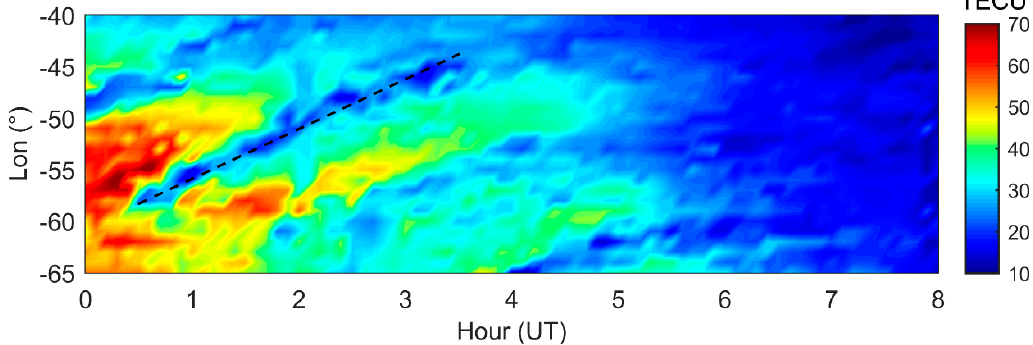
Figure 10. Keogram of VTEC values in terms of longitude and hour at the latitudinal section of 24°S during DOY 32 from 2014.